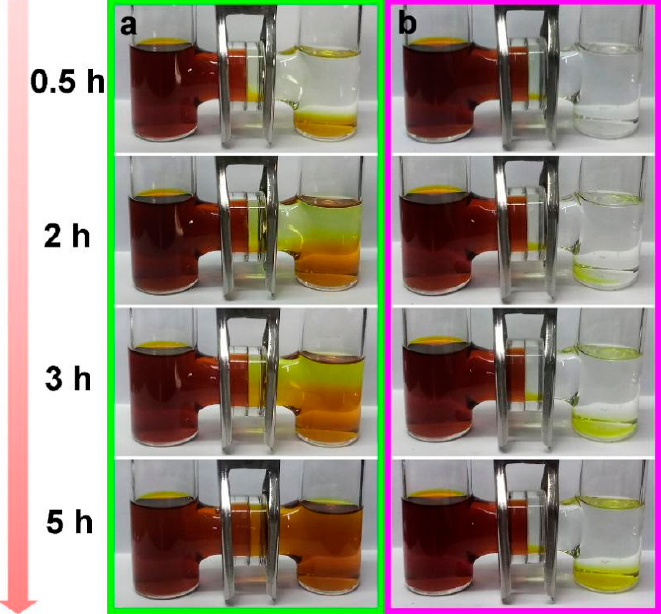
Figure5. Polysulfidepermeationmeasurementsfor( a )routineseparatorand( b Figure 5. Polysulfide permeation measurements for ( a ) routine separator and ( b ) PPS modified separator.